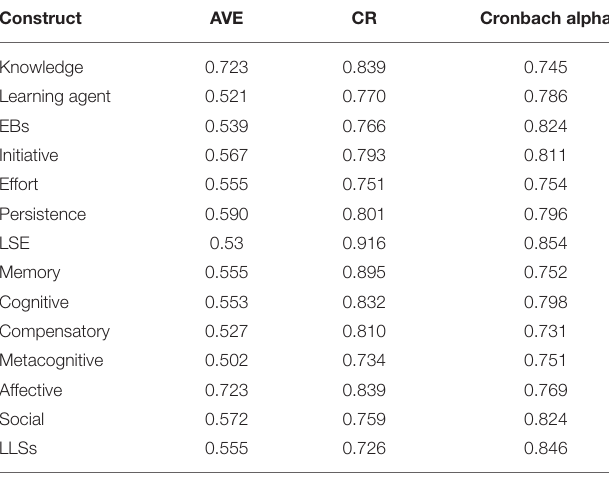
TABLE 5 | Composite reliability for EBs, LSE, and LLSs.